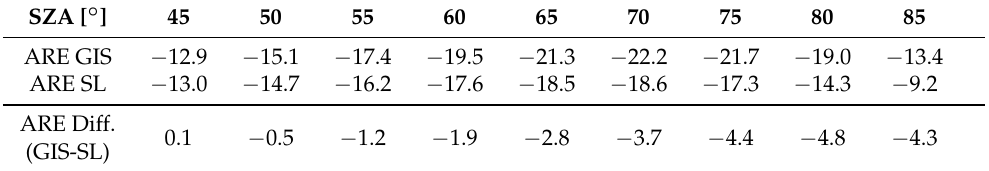
Table 4. Comparison of ARE values over land at sea level (SL) and over the Greenland Ice Sheet (GIS) for different SZA at a constant albedo of 0.8 and AOD of 0.86. ARE values are in Wm − 2 . SZA [ ◦ ] 45 50 55 60 65 70 75 80 85 ARE GIS − 12.9 − 15.1 − 17.4 − 19.5 − 21.3 − 22.2 − 21.7 − 19.0 − 13.4 ARE SL −